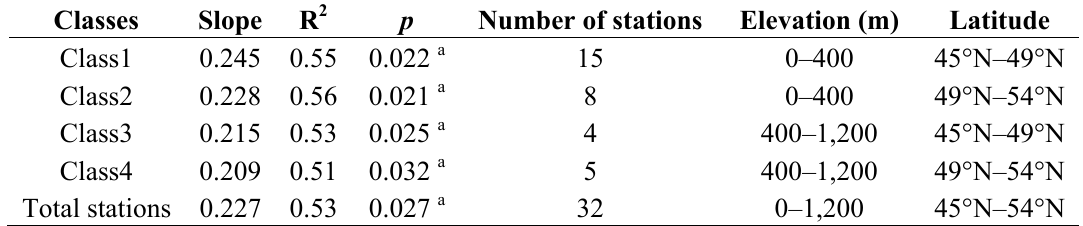
Table 2. Temporal trends of average annual temperature among climate